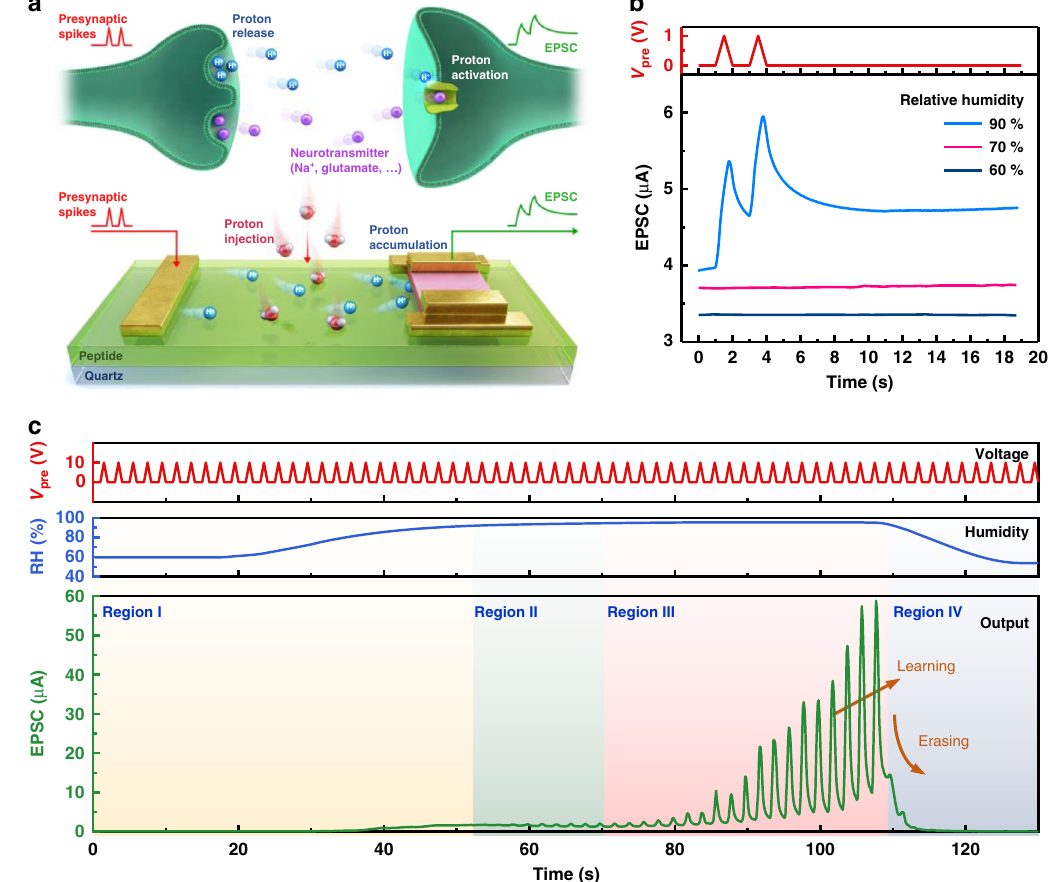
Fig. 4 Proton-activated arti fi cial synapses based on the Y7C peptide. ( a ) Schematics of the proton activation process in biological synapses (top) and arti fi cial synapses (bottom). Presynaptic spikes and corresponding EPSCs are shown in red and green, respectively. In biological synapses, protons (blue) released from presynaptic neurons activate receptors at postsynaptic neurons to receive neurotransmitters (purple). ( b ) Postsynaptic currents of the arti fi cial synapse under various RH conditions triggered by a pair of presynaptic voltage pulses (V = 1 v, Δ t = 1 s). PPF occurred at 90% RH (blue), while there was no presynaptic response at either 70% RH (magenta) or 60% RH (navy). ( c ) Proton-dependent plasticity of arti fi cial synapses. The voltage pulse, RH pulse, and corresponding current output of the device are shown as red, blue, and green curves, respectively. Only when both voltage and RH inputs are activated does a notable learning process appear, and the synaptic response is suppressed drastically by reducing